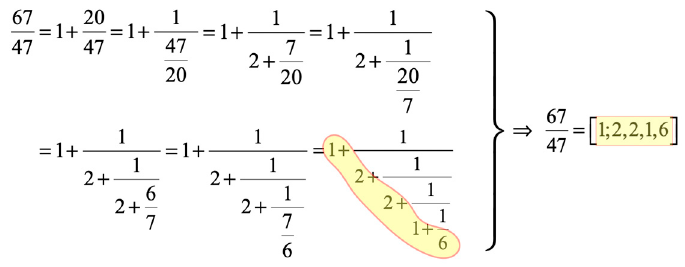
Figure 1. Example of a straightforward computation of a continued fraction.